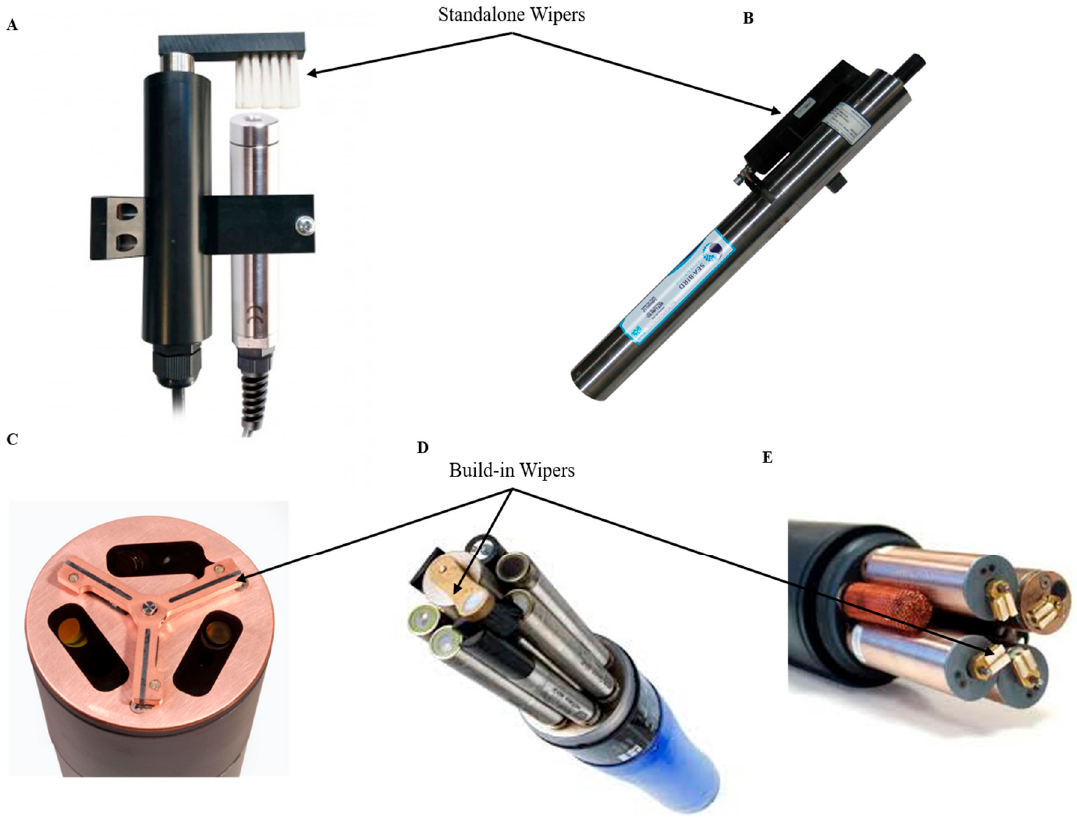
Figure 3. Standalone and build-in antifouling wipers overview. ( A ) Ponsel Dissolved Oxygen and Turbidity Sensors + antifouling wiper [62]; ( B ) SUNA V2 Nitrate sensor [63]; ( C ) ECO Triplet-w Sea-Bird Scientific sensor [64]; ( D ) YSI EXO 2 multi-parameter sonde [61]; ( E ) YSI 6 series multi-parameter sonde [65] (reproduced with permission of © 2020 YSI, a Xylem brand, Yellow Springs, OH, USA and Sea-Bird Scientific, Bellevue, WA, USA).